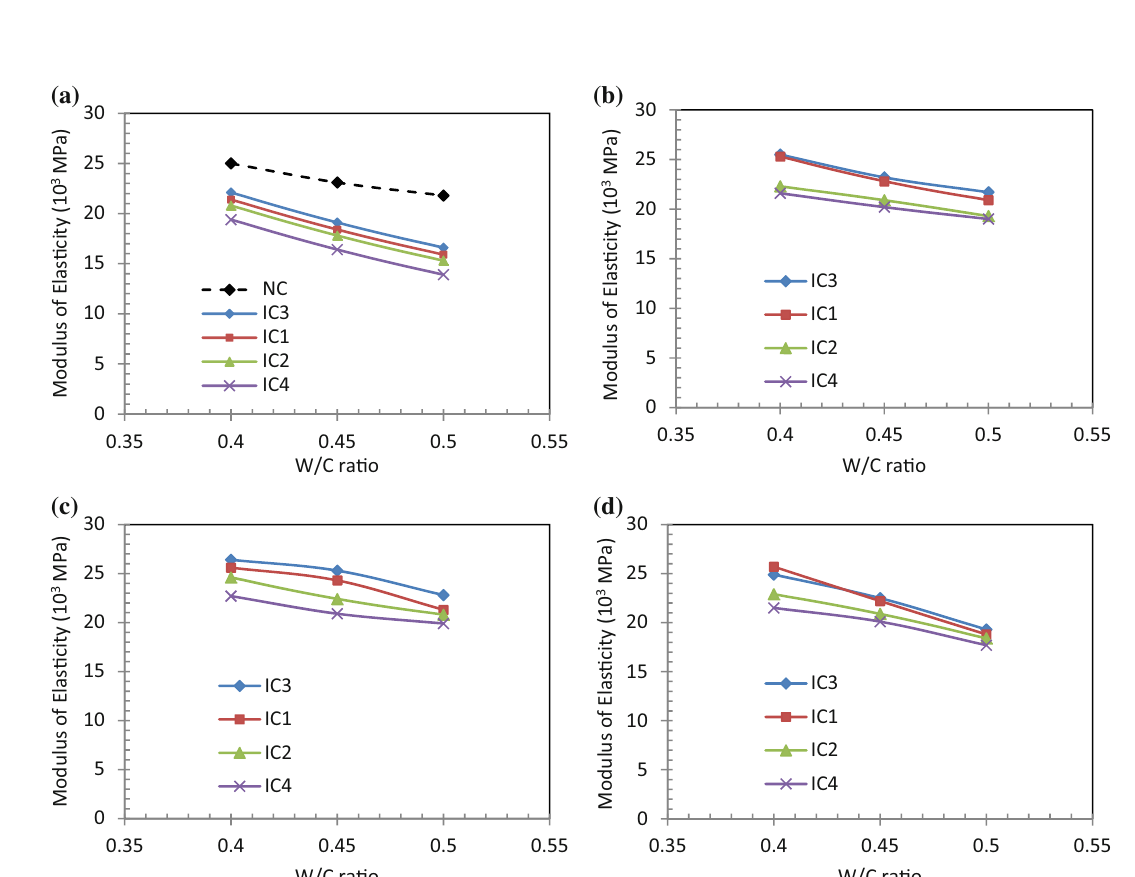
Fig. 7 Effect of w/c ratio on modulus of elasticity of samples a control samples with 0% replacement b IC samples with 10% replacement c IC samples with 20% replacement d IC samples with 30% replacement.